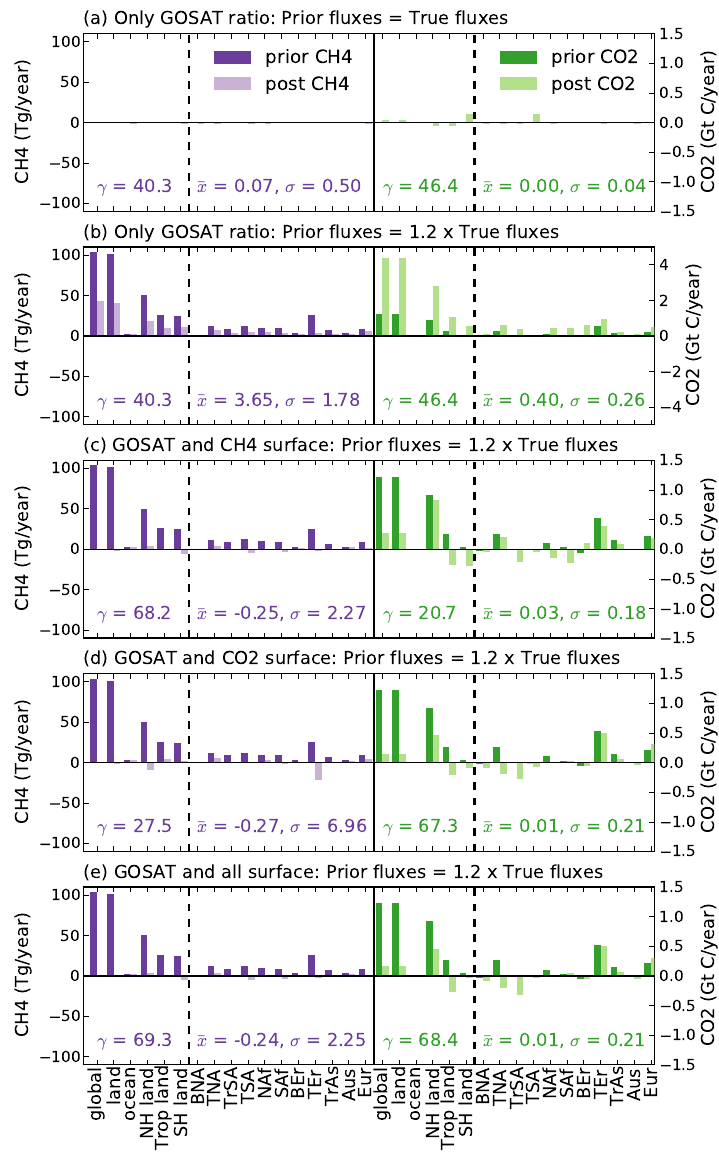
Figure 6. Annual regional flux estimates of CH 4 (left) and CO 2 (right) inferred from various observing system simulation experiments, where values are described as the departure from the corresponding true flux. The first six regions are aggregates: global represents all regional fluxes; land omits the oceans and vice versa; NH land sums fluxes from Boreal and Temperate North America, Europe, and Boreal and Temperate Eurasia; Trop land sums fluxes from Tropical South America, Northern Africa, and Tropical Asia; and SH land sums fluxes from Temperate South America, Southern Africa, and Australasia. The remaining regions are defined in Fig. 1. For experiment (a) the a priori and the truth are the same and only GOSAT data are used; experiment (b) is as (a) but the a priori fluxes are 20% higher than the truth; experiment (c) is as (b) but CH 4 surface flask data are also used; experiment (d) is as (b) but CO 2 surface flask data are also used; experiment (e) is as (b) but CH 4 and CO 2 surface flask data are also used. Note the different y-scale for CO 2 in (b) . The error reduction in the global fluxes ( γ ), the mean ( x ) and standard deviation ( σ ) of the difference in the individual regions are shown inset in each panel.